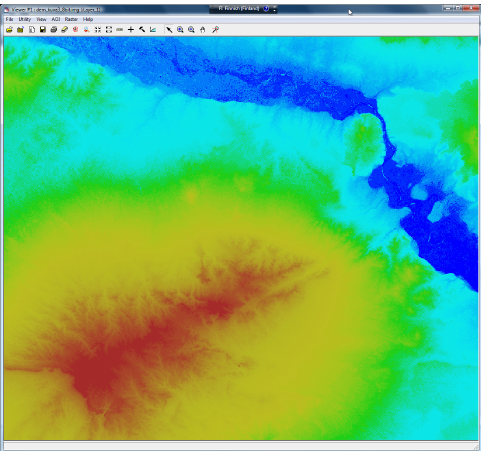
Figure 2. Jebel Bishri, the Euphrates trough and the oval volcanic and basaltic outcrop known as the peninsula of Halabiya visible on ASTER images. Compiled and coloured by M. Törmä 2012.